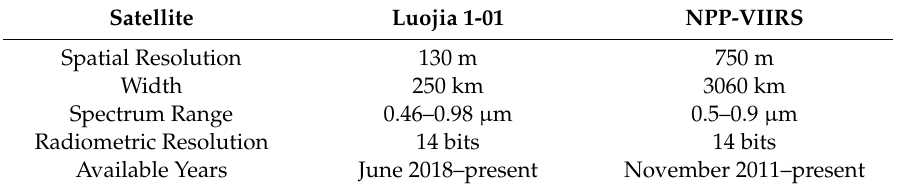
Table 1. Introduction to Specifications of Luojia 1-01 and NPP-VIIRS